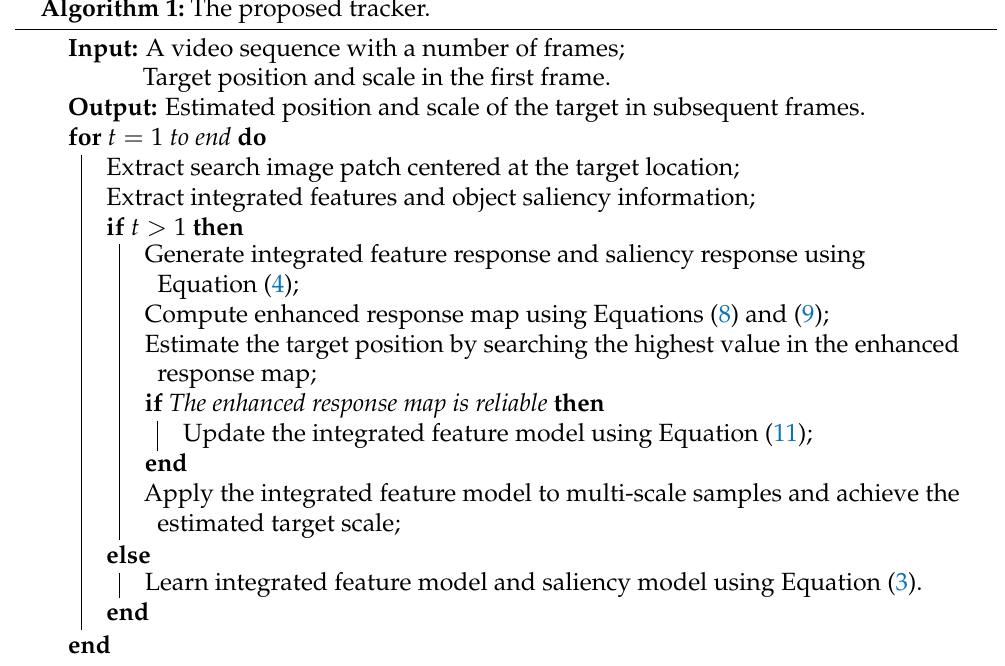
Algorithm 1: The proposed